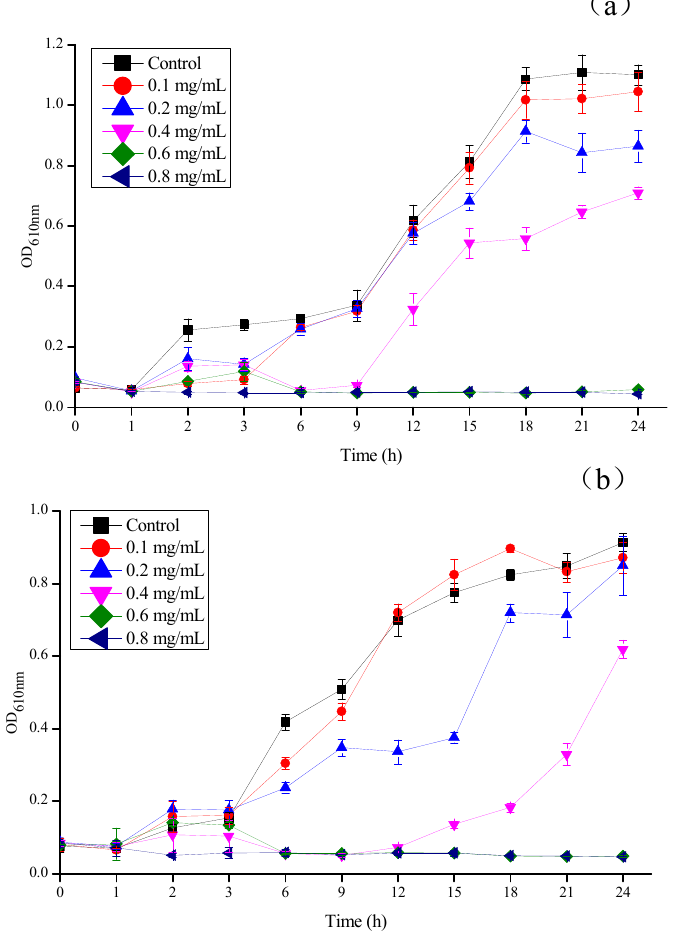
Figure 5. Growth inhibition of ( a ) E. coli and ( b ) S. aureus under different concentrations of CSNP solutions (mg/mL). The growth inhibition was measured as turbidity (OD 610 nm ) for 24 h at 1 h inter-